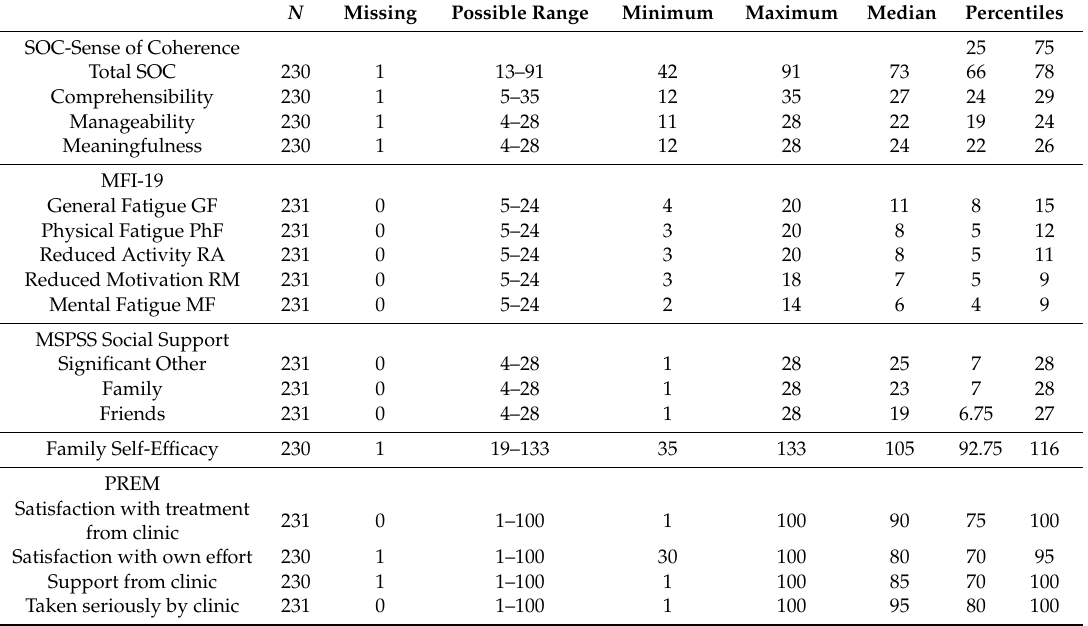
N Missing Possible